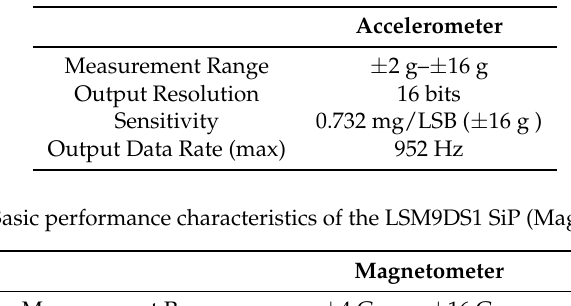
Figure 2. System-level diagram ( a ) and picture ( b ) of the implemented measurement platform. The basic performance characteristics of the LSM9DS1 SiP are presented in Tables 1 and 2. Table 1. Basic performance characteristics of the LSM9DS1 SiP (Accelerometer).